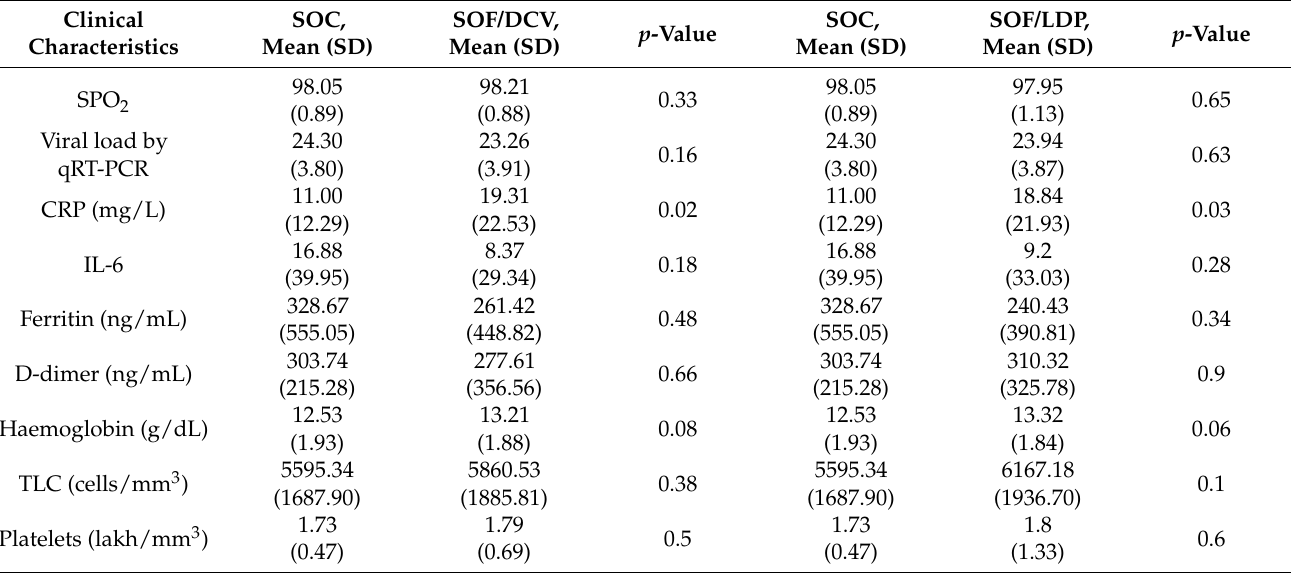
Table 2. Baseline clinical and laboratory features of the study participants.